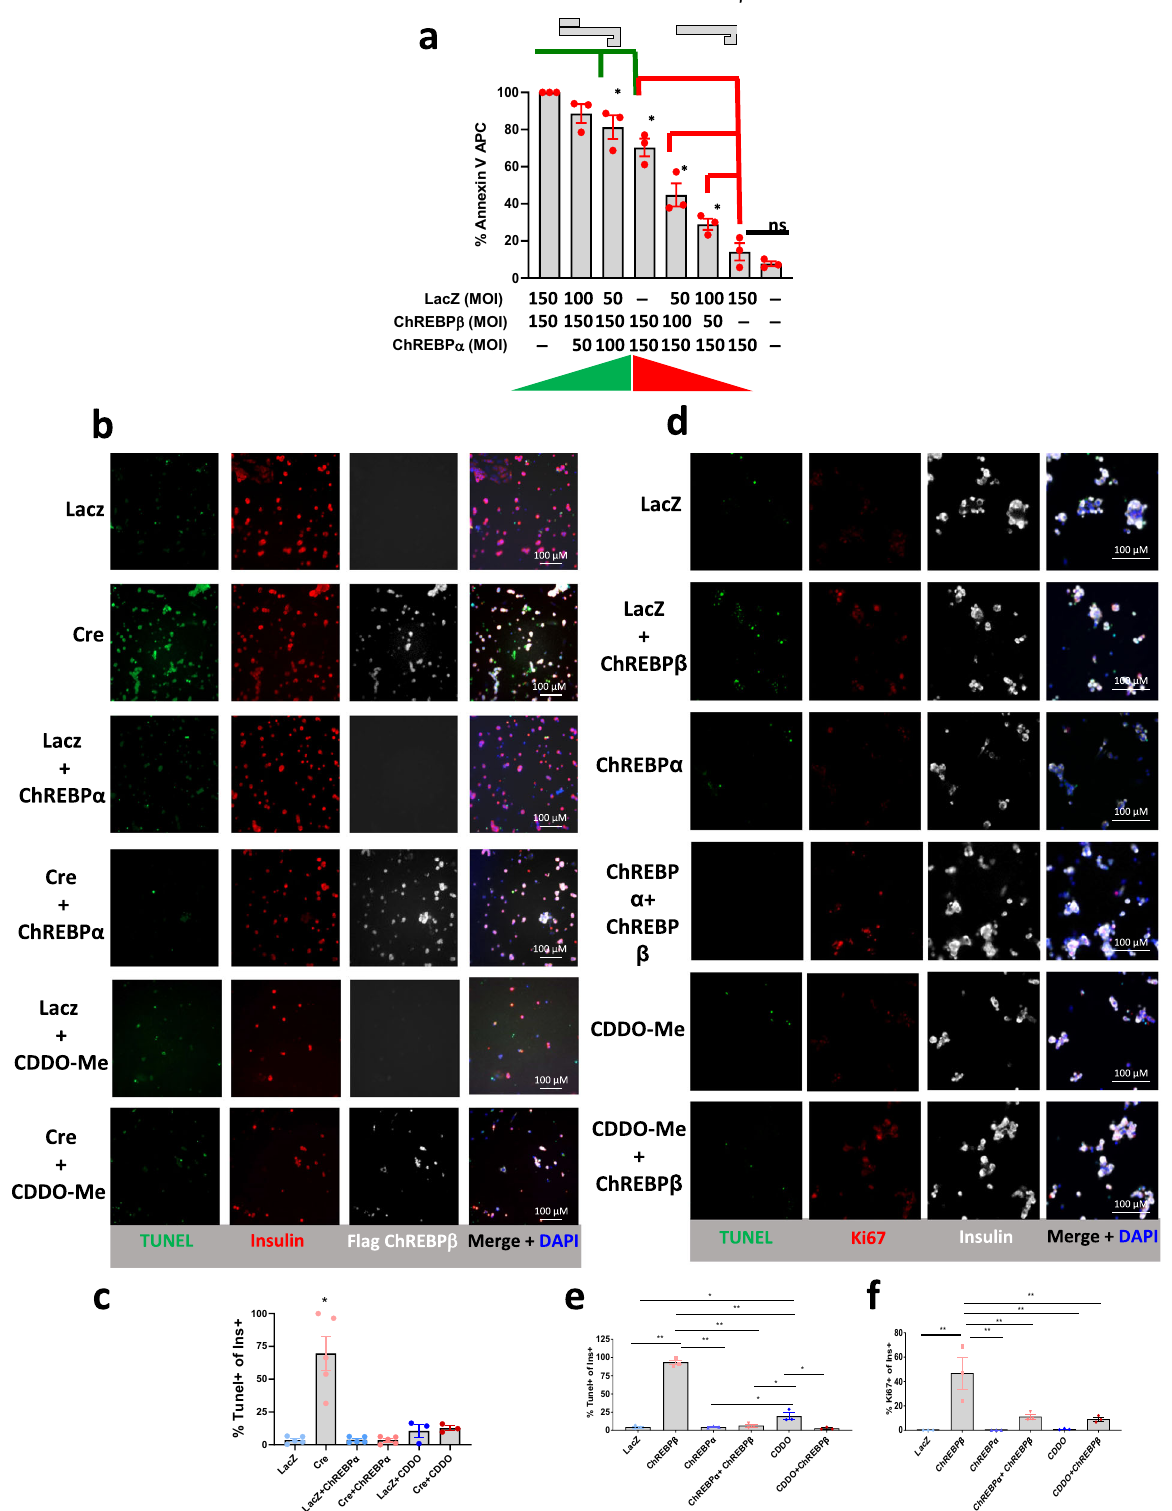
Fig. 8 | ChREBP α and activation of Nrf2 mitigates ChREBP β -mediated β -cell death. a The indicated amounts of ChREBP α and ChREBP β were transduced into INS-1-derived 832/13 cells and 48h later apoptosis was measured with Annexin V staining. Error bars are SEM, N =3, * p <0.05. b Islets were isolated from Lox-Stop- Lox ChREBP β mice, dispersed and transduced with the indicated adenovirus or 10 µ MCDDO-Mefor48h.CellswereimmunostainedorprocessedforTUNELassay